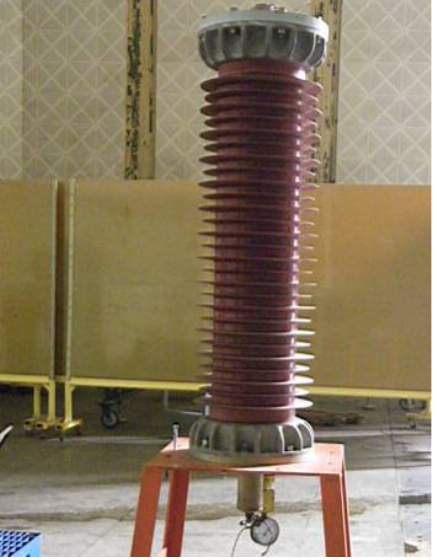
Figure 3. Drawing of the test tooling and pictures of plate electrodes.